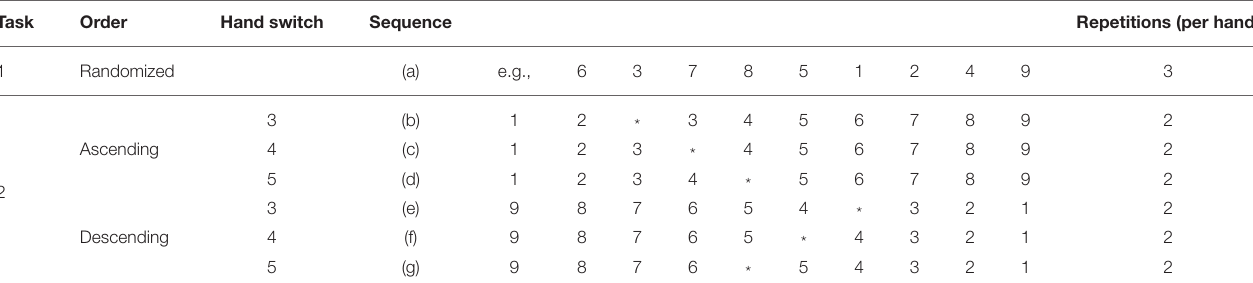
TABLE 1 | Sequences used in the (1) randomized and (2) ordered task. Task